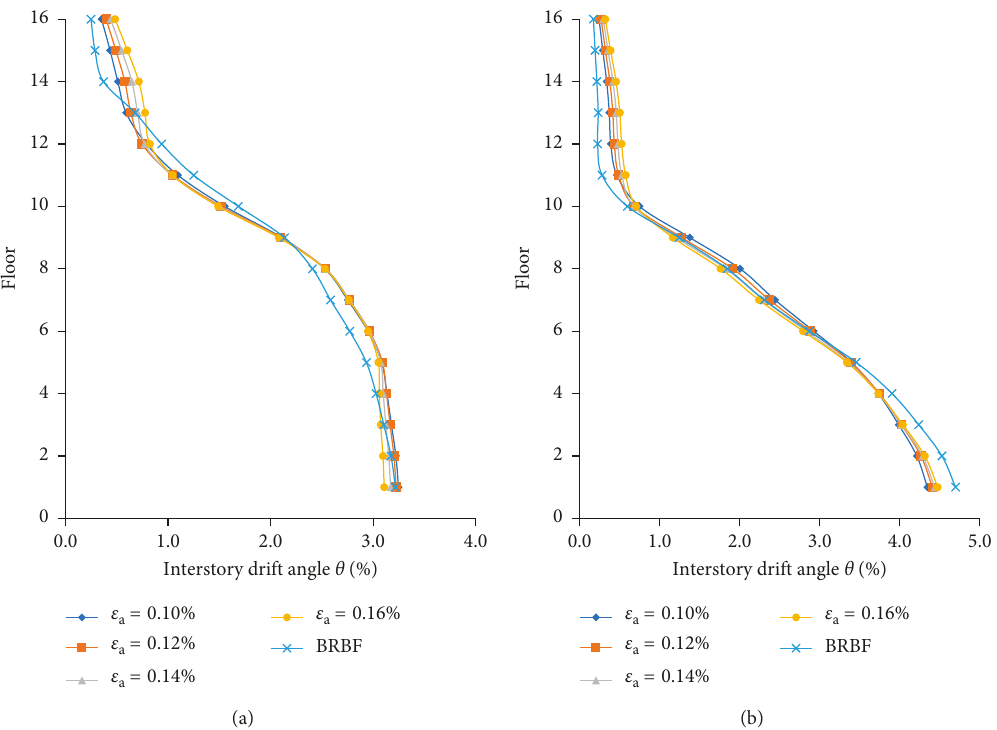
Figure 19: The effects of ε on the interstory drifts of 16-story SC-TOBFs: (a) LD-1 and (b) LD-2. a